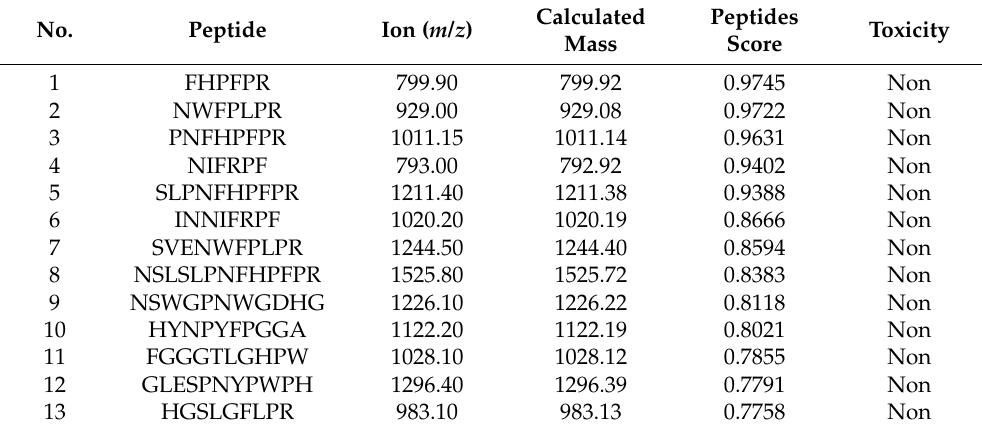
Table 1. Identification of quinoa peptides (fraction < 5 kDa) and their PeptideRanker score and toxicity.